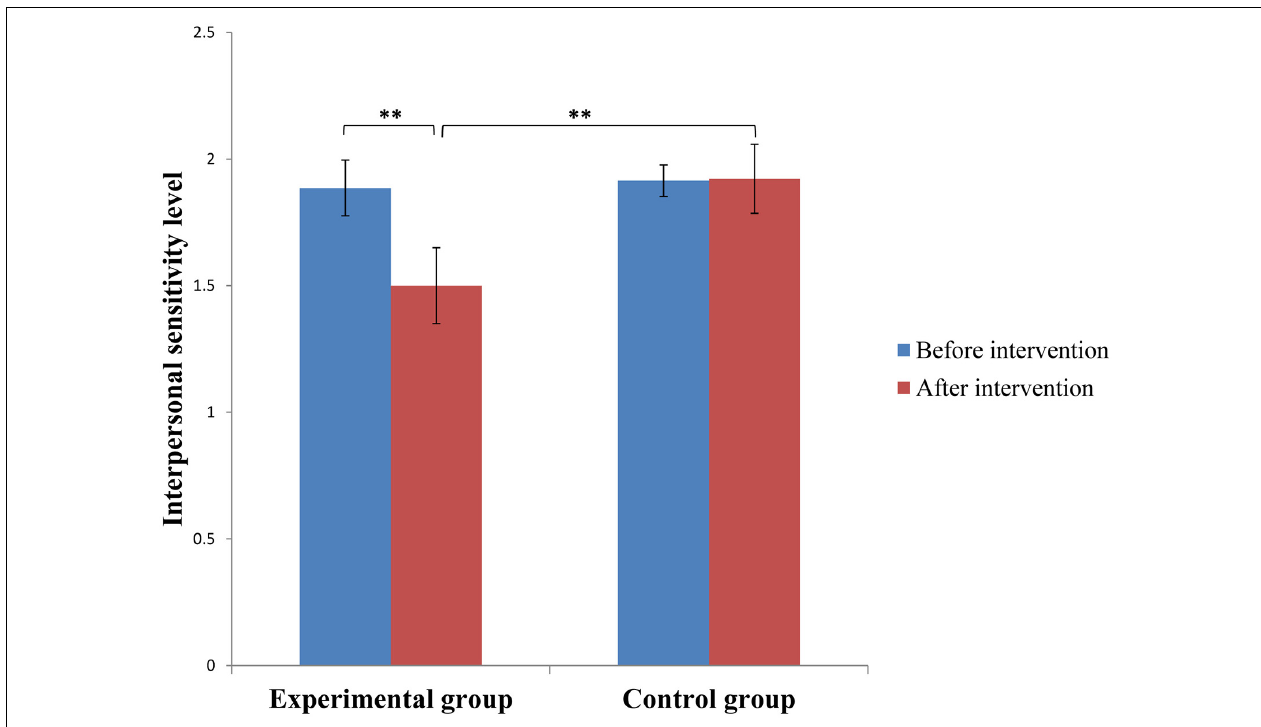
FIGURE 1 | Between-group difference in interpersonal sensitivity level before and after intervention. Error bars represent (–1)/(+ 1)SE; ∗∗ means p < 0.01.